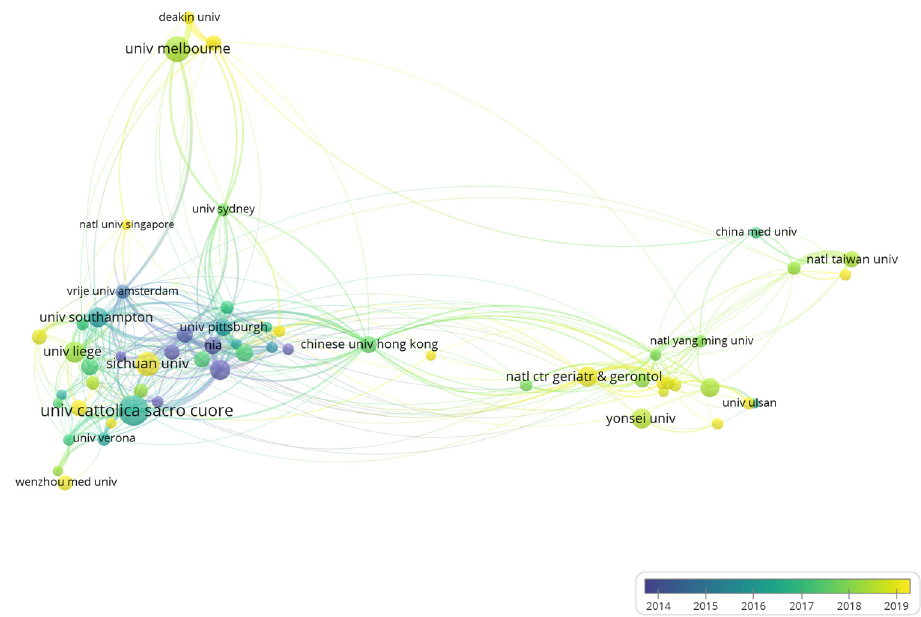
Figure 3. Coauthorship of 58 organizations with at least 20 publications in sarcopenia.